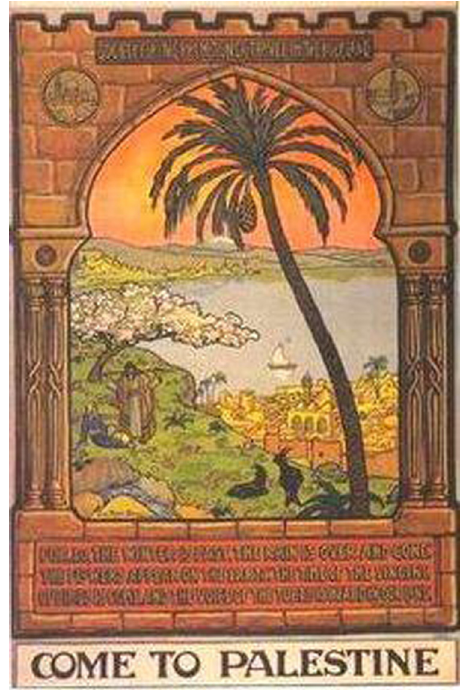
Figure 10: Ze ’ ev Raban, Come to Palestine ,